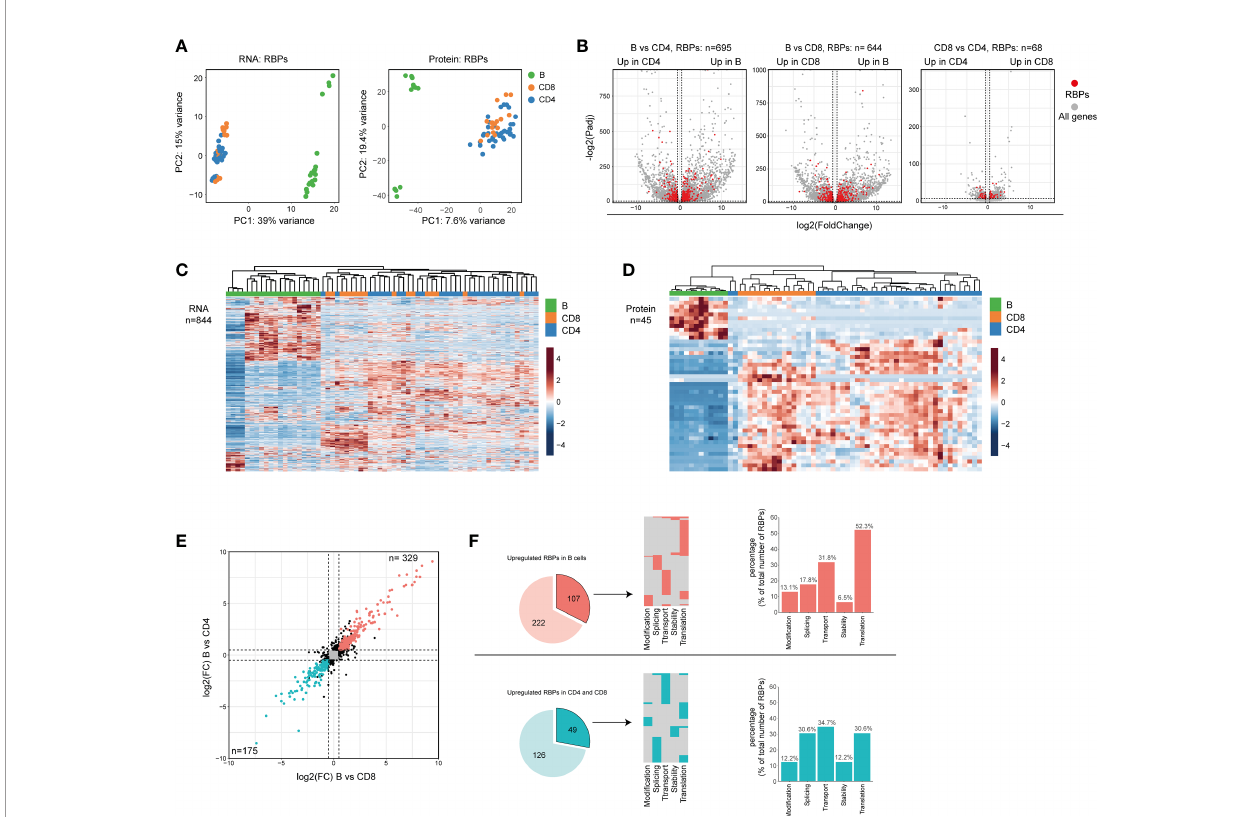
FIGURE 2 | Differential RBP expression between human B cells and T cells. (A) Principal component analysis (PCA) of RBP RNA (left panel) and protein (right panel) expression in CD19 + B cells, CD4 + T cells and CD8 + T cells (n=4 donors). Each dot depicts one speci fi c B cell or T cell subset from each donor. (B) Volcano plots of all differentially expressed genes (gray) and of differentially expressed RBPs (DE RBPs) (red) between CD19 + B cells, CD4 + T cells and CD8 + T cells (LFC>0.5, P- adjusted<0.01). (C, D) Heatmap of unsupervised clustering of DE RBPs at RNA (C) or at protein level (D) in CD19 + B cells, CD4 + T cells and CD8 + T cells. Each column corresponds to one T/B cell differentiation subset of a donor (n=4 donors). (E) Log2 Fold Change (LFC) of RBP mRNA expression between CD19 + B cells and CD4 + T cells (y-axis) and between CD19 + B cells and CD8 + T cells (x-axis). Red dots depict RBPs that are signi fi cantly upregulated in B cells, and blue dots indicate RBPs signi fi cantly upregulated in CD4 + T cells and CD8 + (signi fi cant in both comparisons, LFC>0.5, P-adjusted<0.01). (F) Left panels: RBPs annotated for RNA splicing, stability, subcellular localization of RNA, RNA modi fi cation, and translation (dark colors) or for other processes (light colors) that are upregulated in CD19 + B cells (top row) or T cells (bottom row) as de fi ned in (E) Middle panels: relative distribution between the 5 speci fi c RBP classes. Right panels: Percentage of RBPs annotated for the indicated RNA-related biological